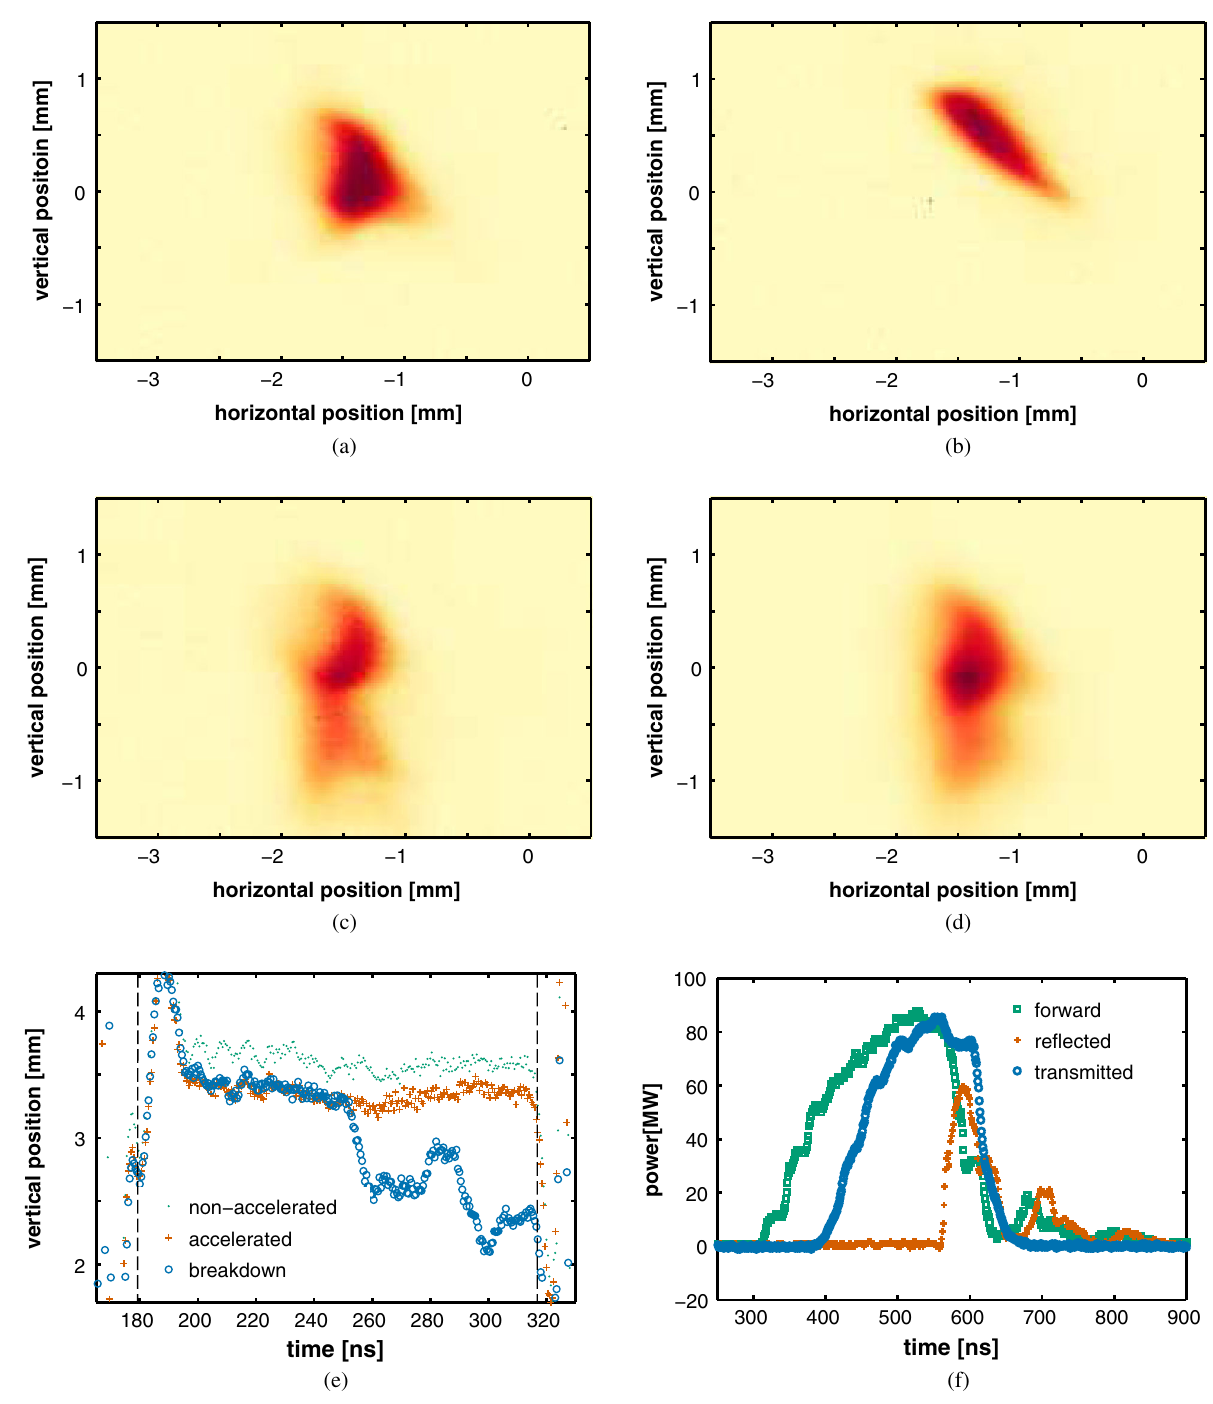
FIG. 4. Collection of measurements from three consecutive bunch trains and prediction of the beam spot in case of rf breakdown: (a) accelerated bunch train; (b) nonaccelerated bunch train; (c) bunch train corresponding to a rf breakdown in the accelerator structure; (d) prediction of the beam spot in case of rf breakdown; (e) beam orbit measurements; (f) power measurements corresponding to a rf breakdown in the accelerator